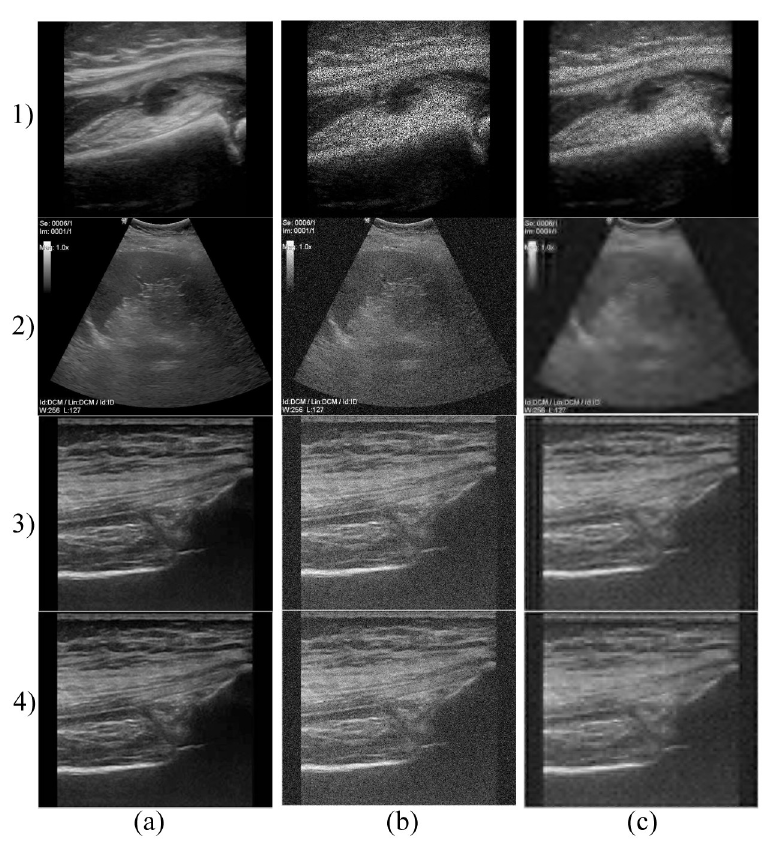
Fig 6. An example of denoising results on different types of datasets using the selected wavelets. 1) Denoising of carotid images using the Db5 , level of decomposition 3. a) native image, b) noisy image (Gaussian noise ( σ 2 = 0.01, μ = 0.05.)) and c) result of noise-canceling procedure; 2) Denoising of abdominal images using Db5 , level of decomposition 4. a) native image, b) noisy image (Gaussian noise ( σ 2 = 0.01, μ = 0.05.)) and c) filtration result; 3) and 4) Denoising of MSK images using the Sym15 (3) and Sym2 (4), level of decomposition 3. a) native image, b) noisy image (Gaussian noise ( σ 2 = 0.01, μ = 0.05.)) and c) filtered MSK image.